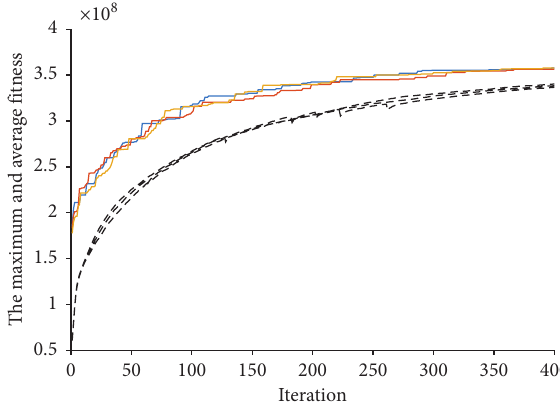
Figure 4: The fitness curve of